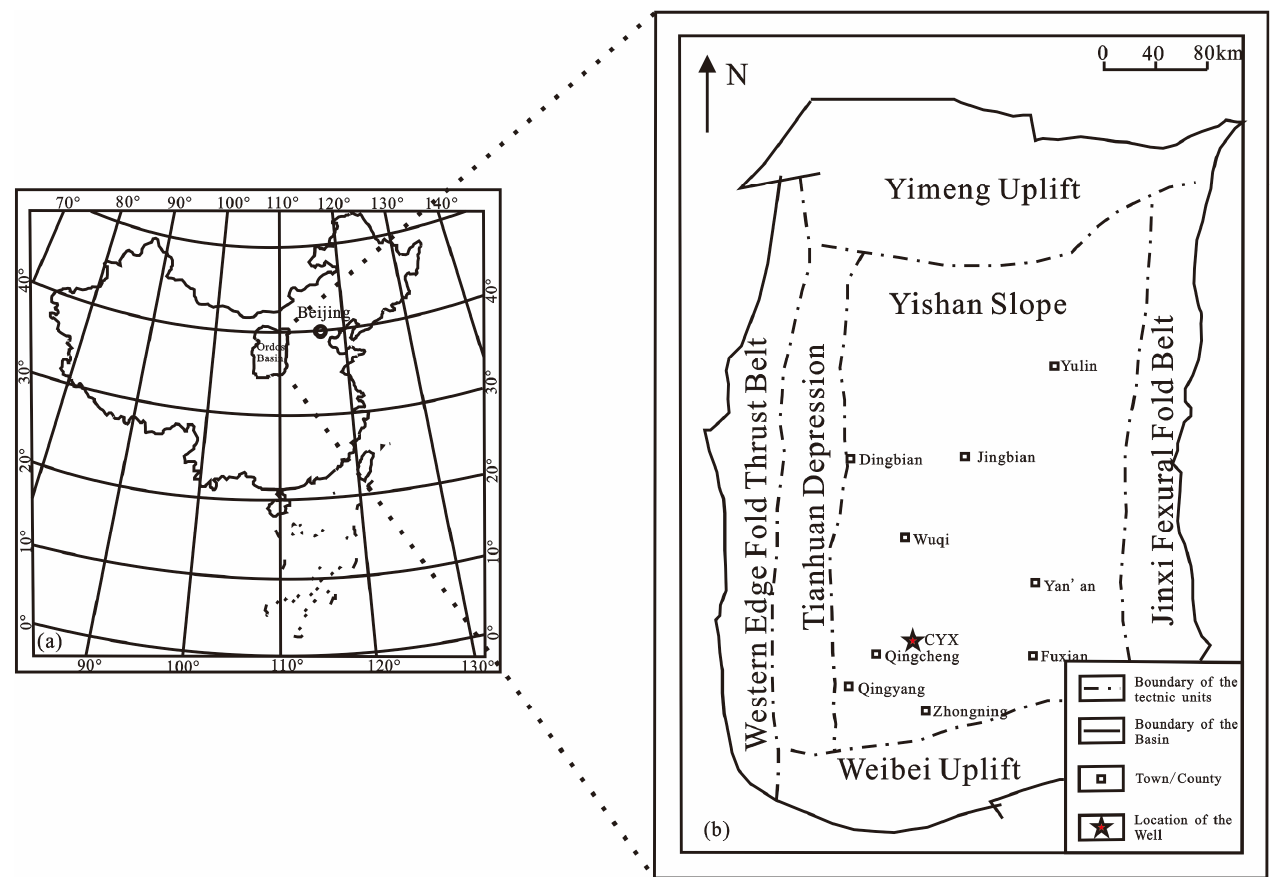
Figure 1. ( a ) Location of the Ordos Basin in China; ( b ) Tectonic units in the Ordos Basin and location of Well CYX (Xu et al. [29]).